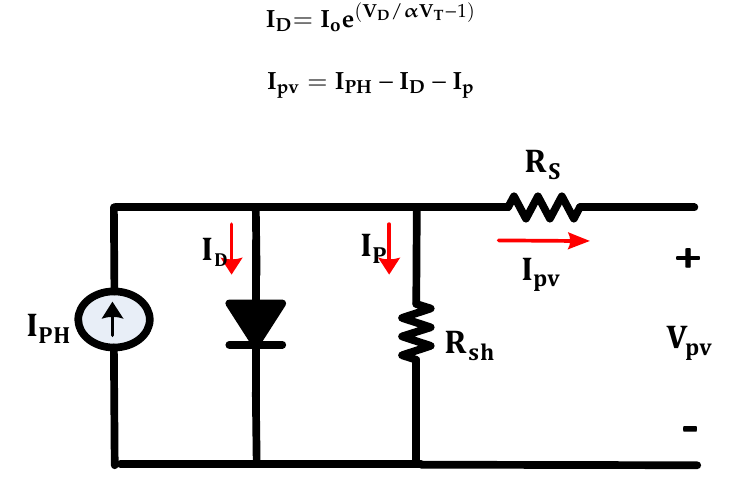
Figure 1. The equations defining this model are: